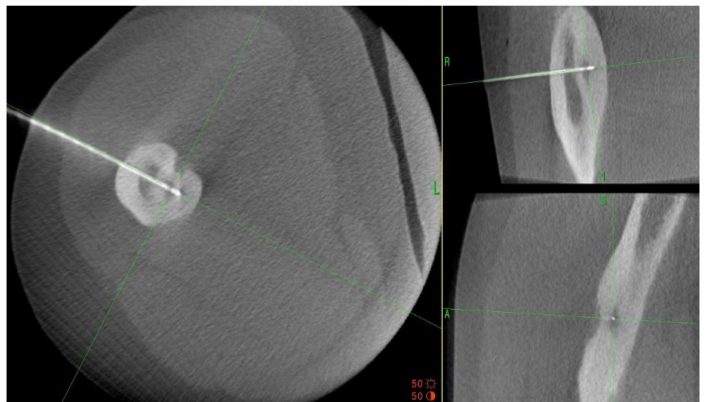
Figure 4. Intraoperative photographs during thermoablation with 3D